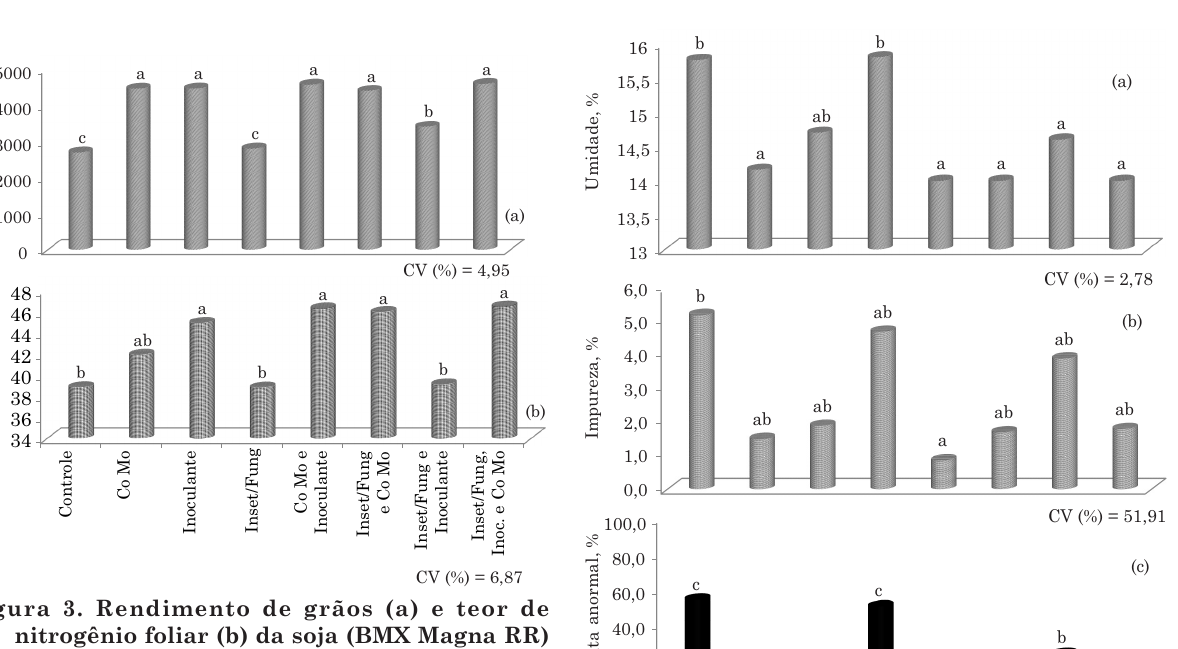
2. Clorose foliar na fase vegetativa da soja, sem a adição de Co, Mo e, ou, inoculante no tratamento de sementes (a) e comparação entre os tratamentos com inoculante e controle, T4 e T1, respectivamente (b, c). Safra